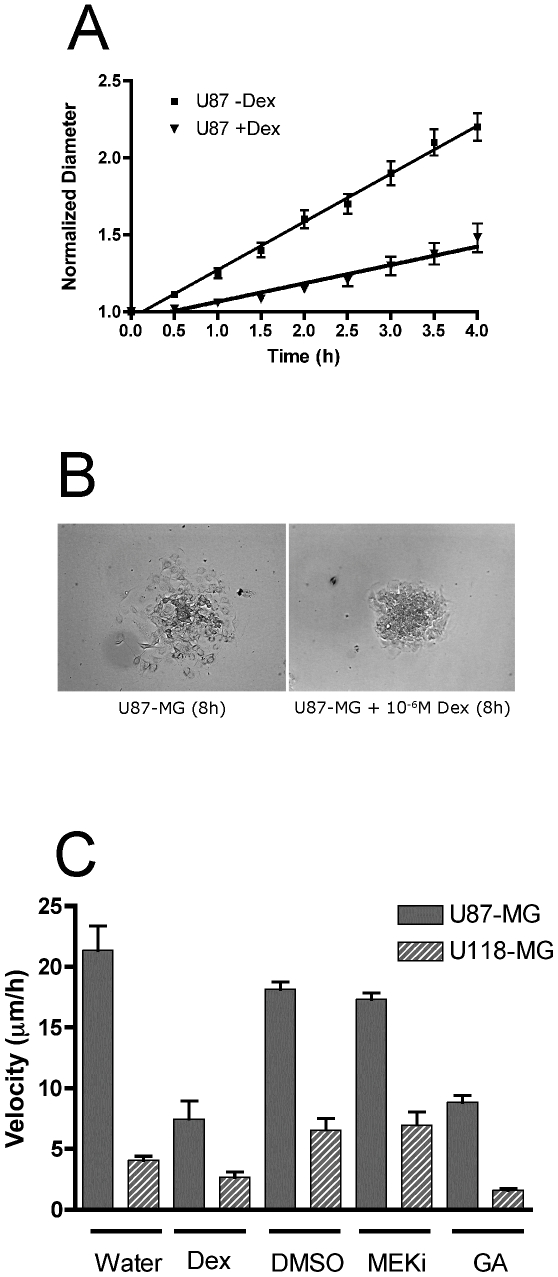
Effects of drug treatment on aggregate spreading velocity.A) Dex treatment significantly reduces the slope of the regression line. Aggregate spreading assays were performed using untreated and Dex-treated aggregates of U87-MG cells. Slopes were found to be significantly different (F-test, P<0.0001), with untreated aggregates having a steeper slope than that of their Dex-treated counterparts. B) Dex treatment promotes cell-cell contact during aggregate spreading. Depicted are phase-contrast images of control and Dex-treated aggregates of U87-MG glioma cells after 8 hours of incubation. Dex treatment markedly reduces spreading and appears to promote cell-cell cohesion at the advancing cell front. C) Spreading velocity of control and drug-treated aggregates. Spreading velocity of aggregates of U87-MG (solid bars) and U118-MG (hatched bars) was compared in response to treatment with Dex, MEKi or GA. Treatment by Dex or GA consistently reduced aggregate dispersal velocity in both cell lines.